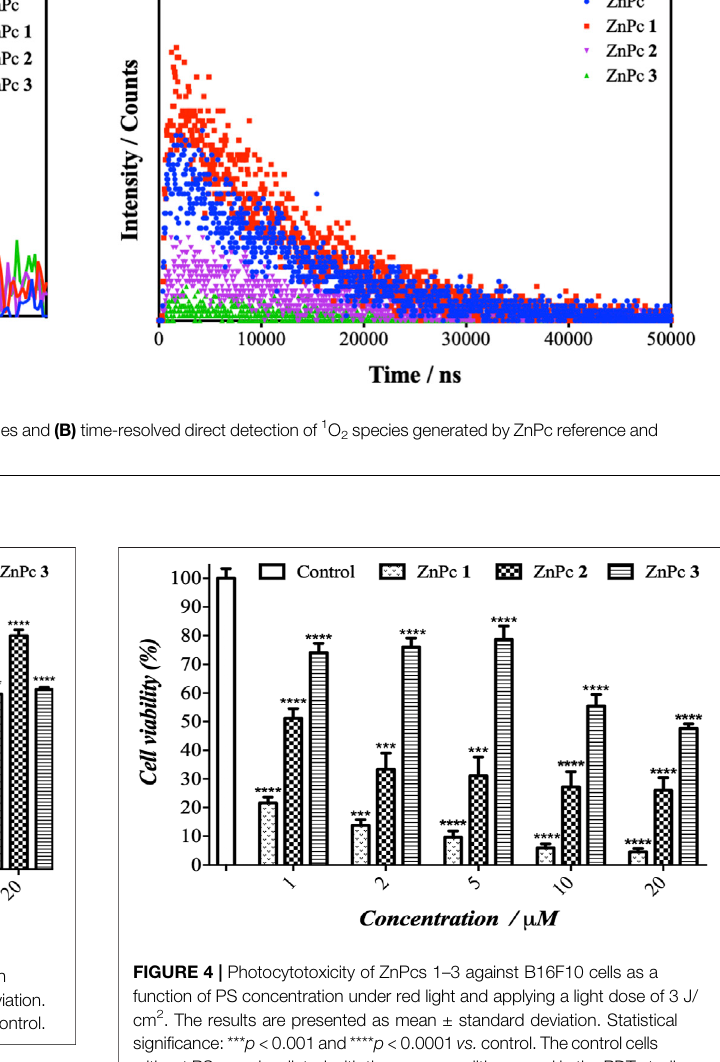
( Table 1 ), which are correlated with the number of thiopyridinium groups and presence/absence of a -F atoms (heavy atom effect) on the phthalocyanine backbone. In fact, the photophysical properties of the studied phthalocyanines could be affected by various molecular aspects, including extended π conjugation, structural distortion, and internal heavy atom. As expected, the fl uorescence is quenched as shown in Table 1 due to the heavy atom effect of F atoms. On the other hand, the lowest V D observed for ZnPc 3 maybe due to the combination of other effects resulting in low spin orbital coupling with consequent decreases in the triplet quantum yield. Since the triplet state decays at a relatively faster rate, the ef fi ciency of oxygen quenching of the triplet state decreases. In addition, due to its slightly lower solubility compared to ZnPc 1 and ZnPc 2 because of interactions, fl uor – fl uor and fl uor – hydrogen cannot be ruled out (Murray et al., 2021).